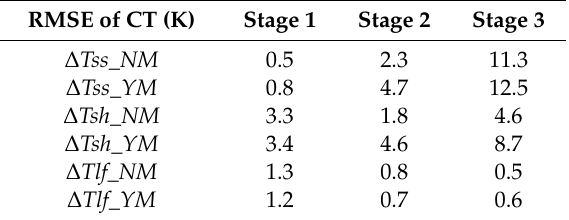
Figure 6. The results of component temperature (CT) inversion. ( a ) Growth stage 1, ( b ) growth stage 2, and ( c ) growth stage 3. Tss_NM and Tss_YM represents the sunlit soil temperature retrieved by the new model and the Yu model separately. Tsh_NM and Tsh_YM represents the shaded soil temperature retrieved by the new model and the Yu model separately. Tlf_NM and Tlf_YM represents the leaf temperature retrieved by the new model and the Yu model separately. Table 3. RMSE of component temperature (CT) inversion at the three growth